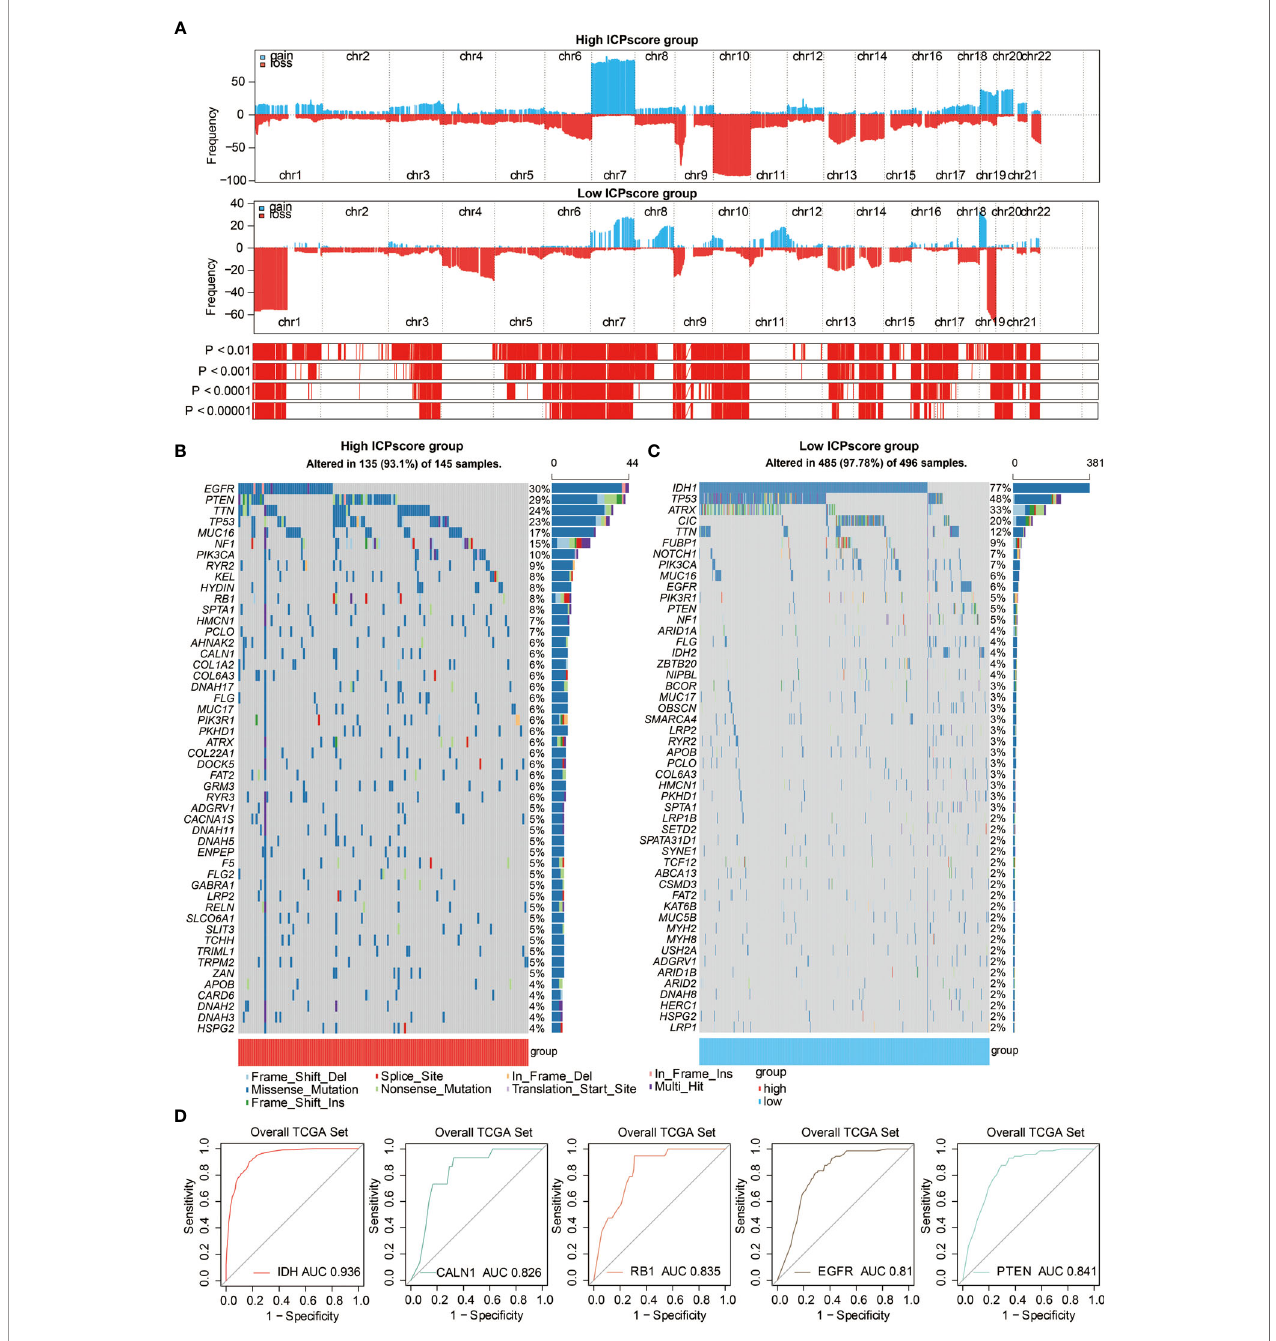
FIGURE 5 | Genomic features of ICP score. (A) GISTIC 2.0 distribution of gain or loss of function mutation in gliomas with high and low ICP score. Chromosomal locations of peaks of signi fi cantly recurring focal ampli fi cations (red) and deletions (blue) are presented. (B) List of the most frequently altered somatic mutation genes in the high ICP score group. (C) List of the most frequently altered somatic mutation genes in the low ICP score group. (D) ROC curve measuring the sensitivity of ICP score in predicting IDH, CALN1, RB1, EGFR, and PTEN mutation status. The area under the ROC curve was 0.936, 0.826, 0.835, 0.81, and 0.841,